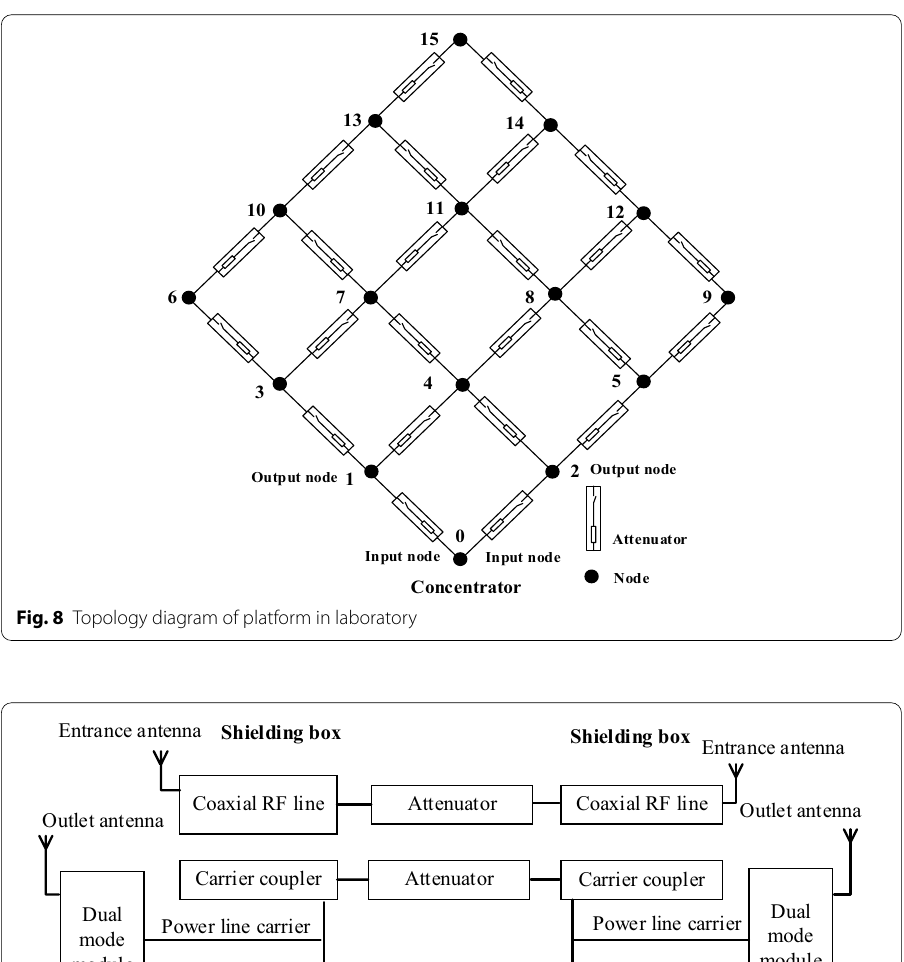
Fig. 9 Connection diagram of test equipment inside and between shielding